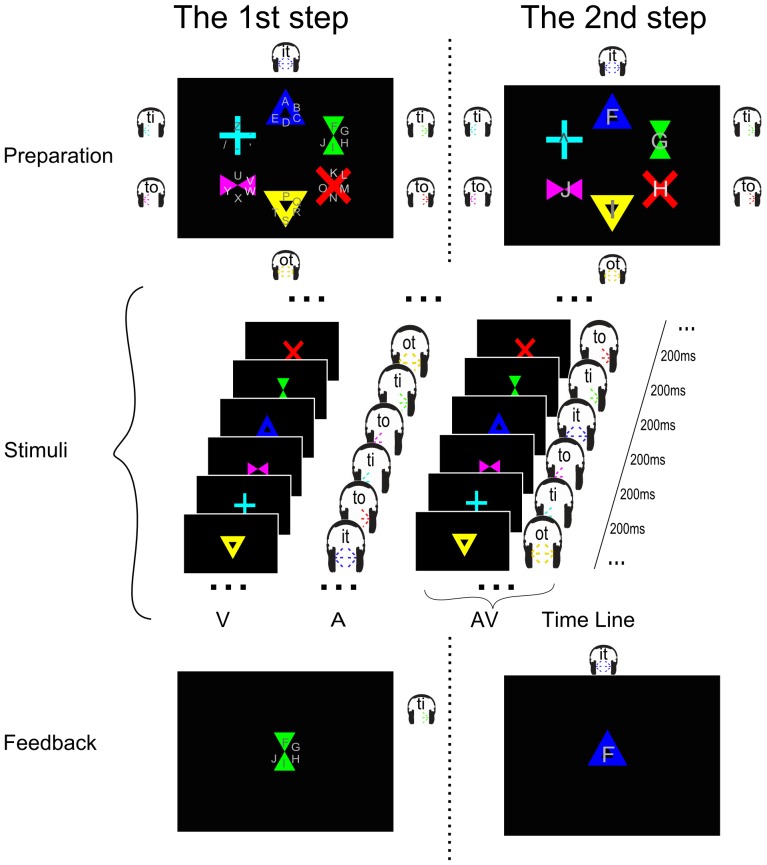
Visualization of the experimental design of the experiment for unimodal speller (Visual: V and Auditory: A) and Combined-Speller (AV).The left column shows the first selection period for group selection. The right column shows the second selection period for symbol selection. The upper channel shows the ‘target cue’ part before stimuli start, including the cue for showing the position (or voice) of the target and the countdown part for hint of the start. The middle panel shows the time sequence of each stimuli paradigm. The lower panel shows the feedback after each selection period. For the first selection period, the group of the target symbol was chosen, and the symbols in that group will re-distributed into these six visual shapes (the last shape, light blue cross, was left blank as the ‘backdoor’ symbol) according to their position in the chosen group.